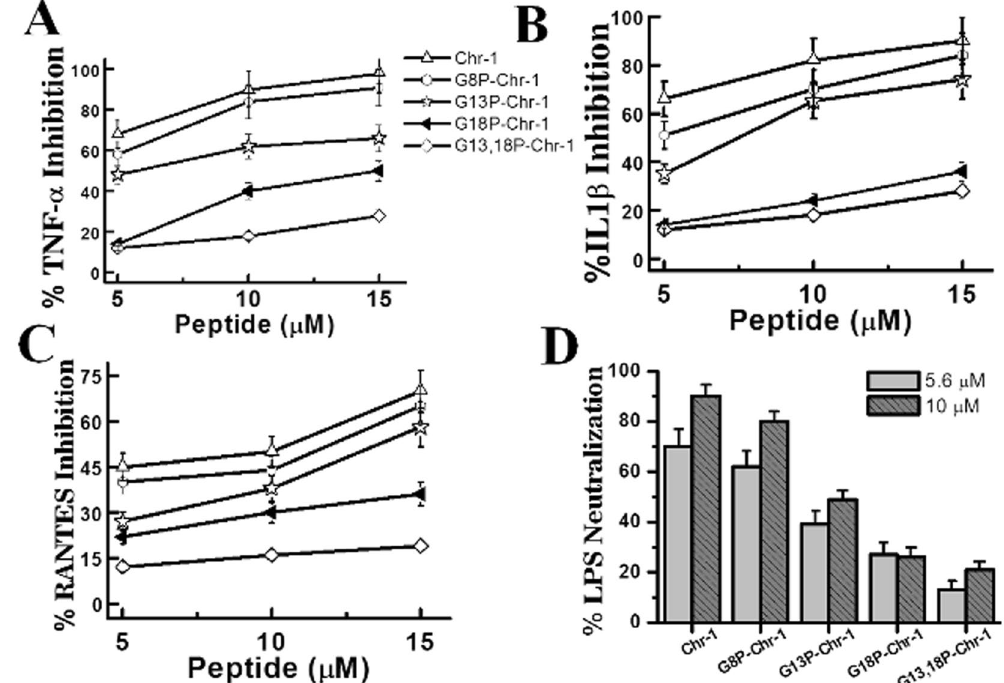
Figure 6. Effect of Chrysophsin-1 and its variants on the production of TNF- α in LPS-stimulated human monocytes: ( A ) Percentage inhibition of TNF- α production in LPS-stimulated THP-1 cells in concentration dependent manner. ( B ) IL1 β inhibition by the peptides. ( C ) Dose-dependent inhibition of RANTES in response to LPS with increasing peptide concentrations. ( D ) LAL assay of peptides to show their binding to LPS at two different concentrations. Symbols as indicated in A.